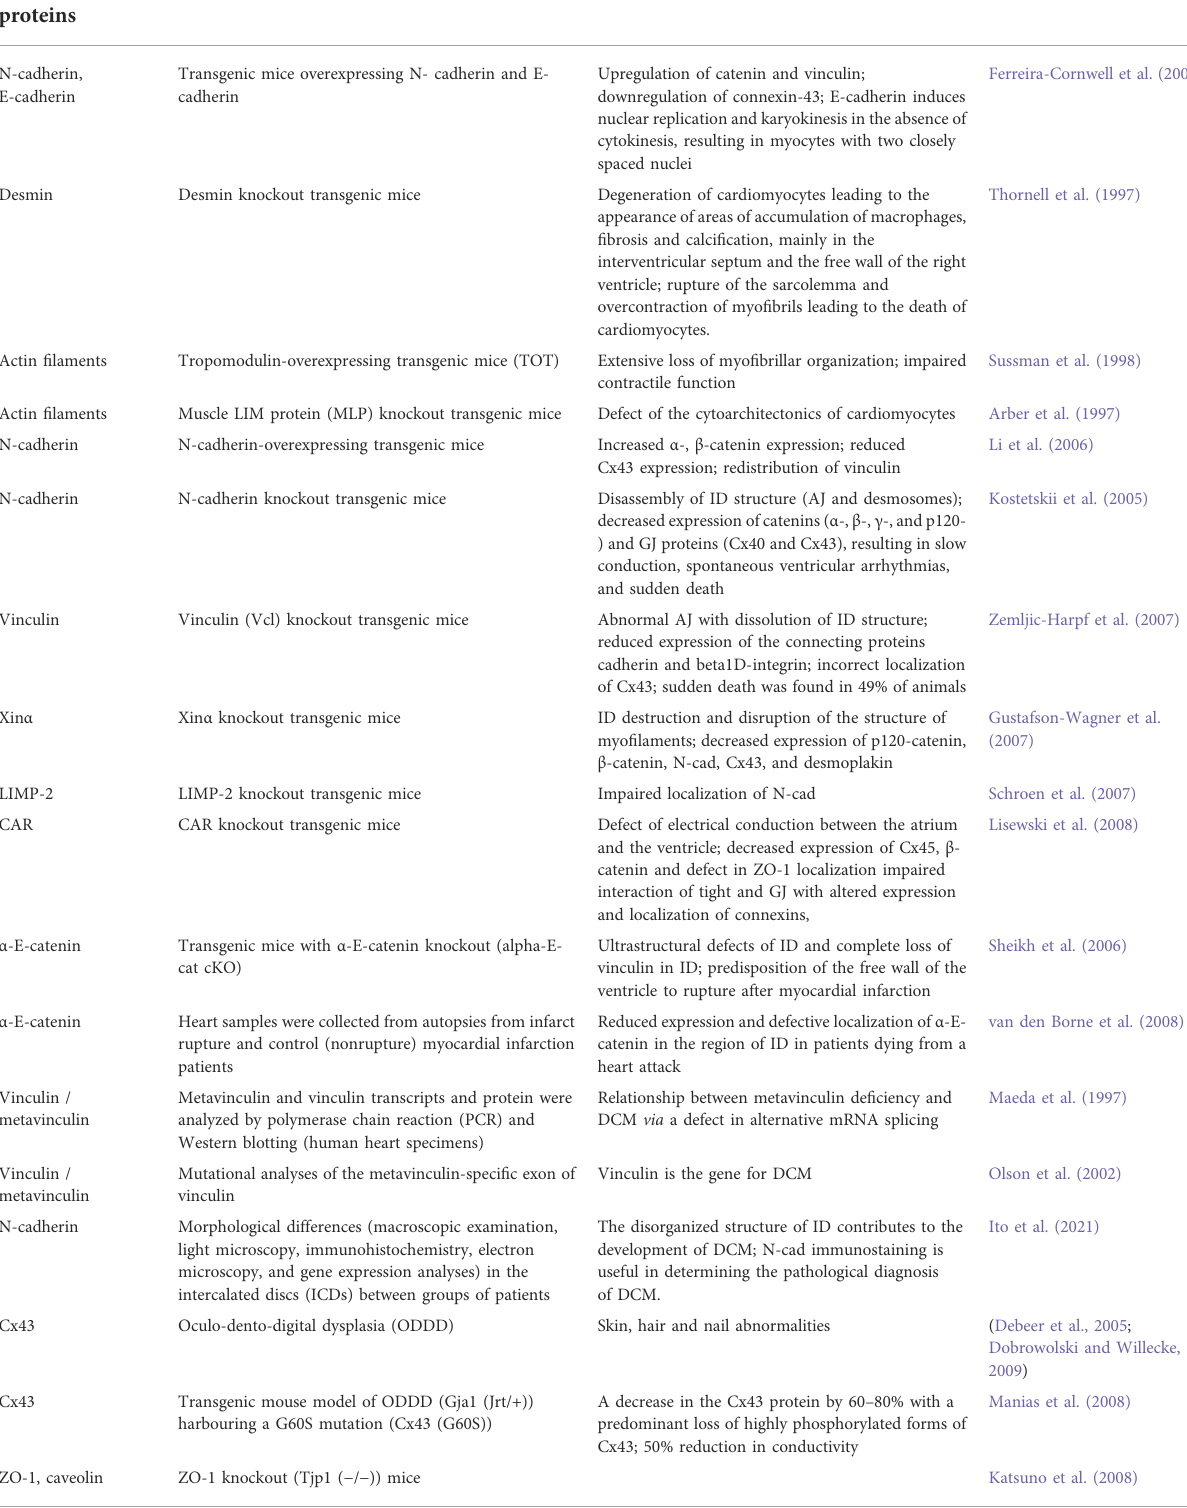
TABLE 1 The role of intercalated disc proteins in the development of the DCM phenotype. Intercalated disc